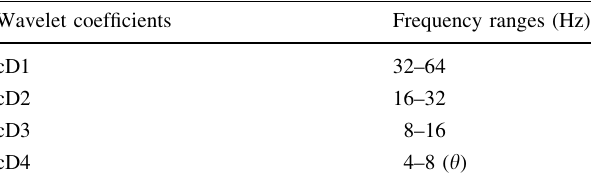
Table 1 Frequency ranges related to detail wavelet coefficients with sampling frequency 128 Hz Wavelet